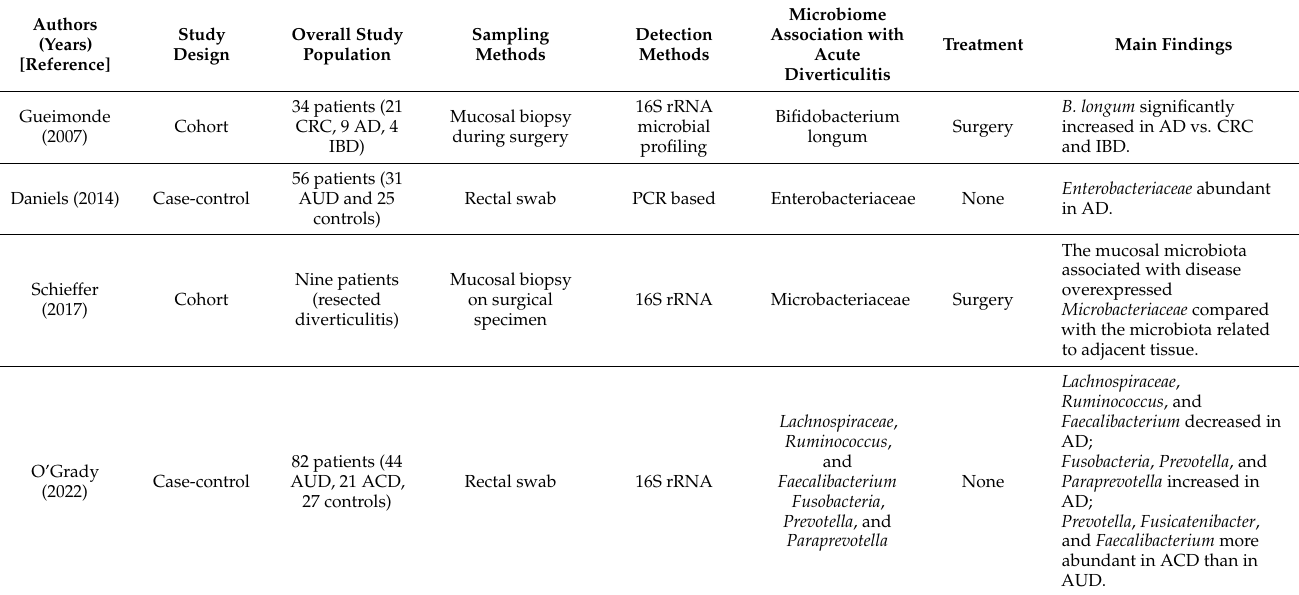
Table 3. Microbiota characterization in acute diverticulitis